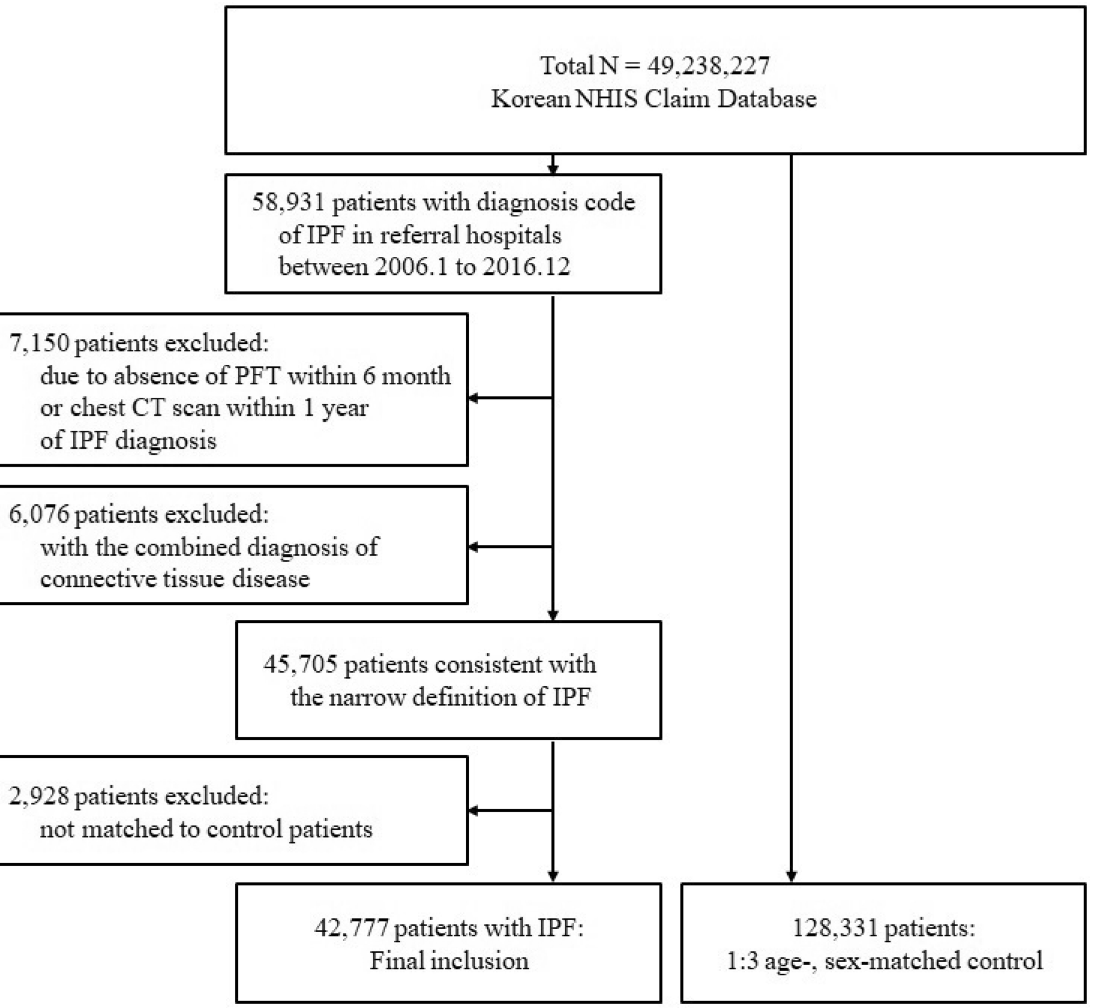
Figure 1. Inclusion flow chart. NHIS National Health Insurance Service, IPF idiopathic pulmonary fibrosis, PFT pulmonary function test, CT computed